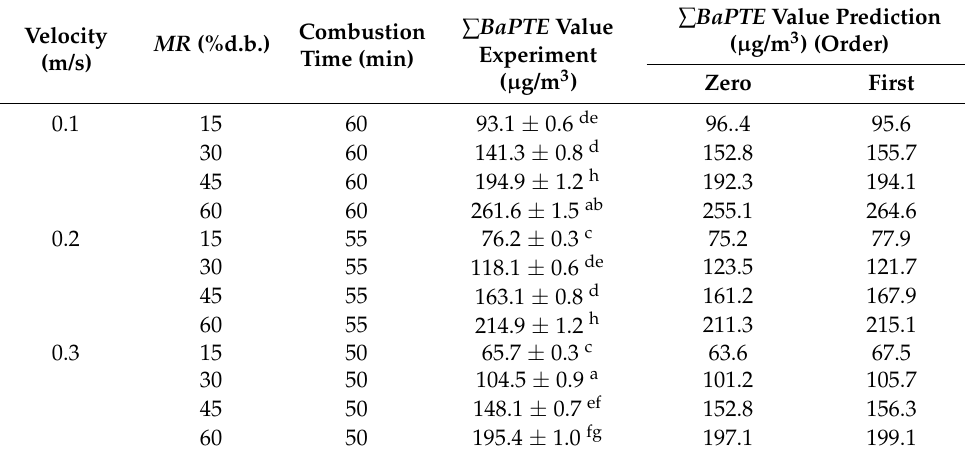
a–h Different letters in the same column indicate a significant difference at p -value ( p <